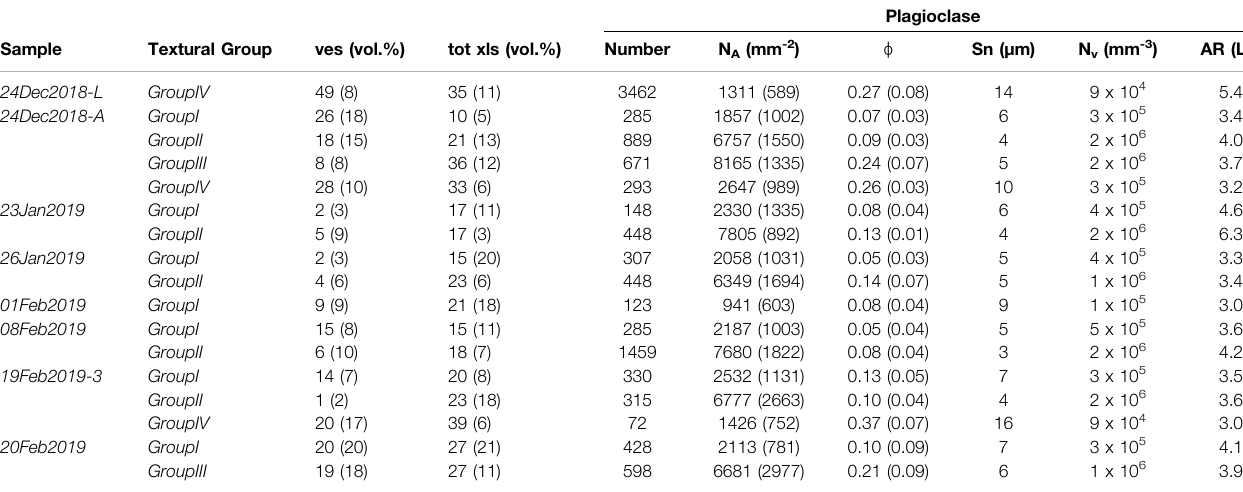
TABLE 2 | 2D textural parameters obtained on BSE-SEM images.